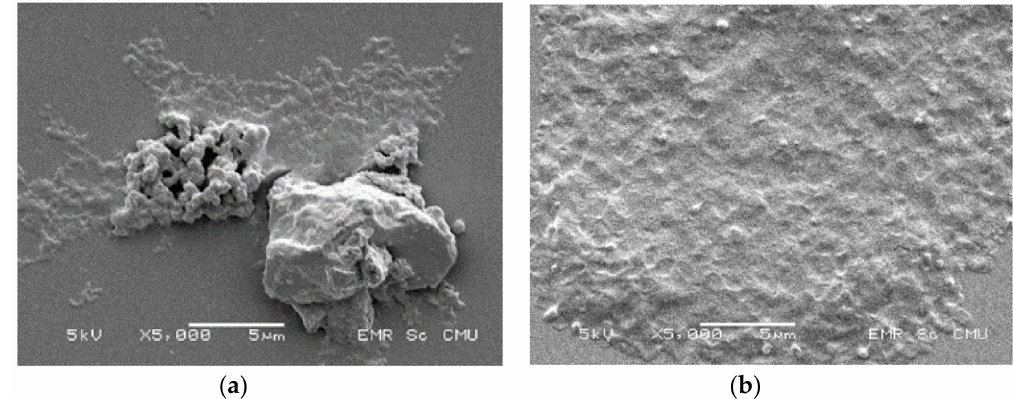
Figure 6. SEM images of anti-TNF-alpha coating on Si using ( a ) APTES-GA technique and ( b ) APTES-(EDC/NHS)